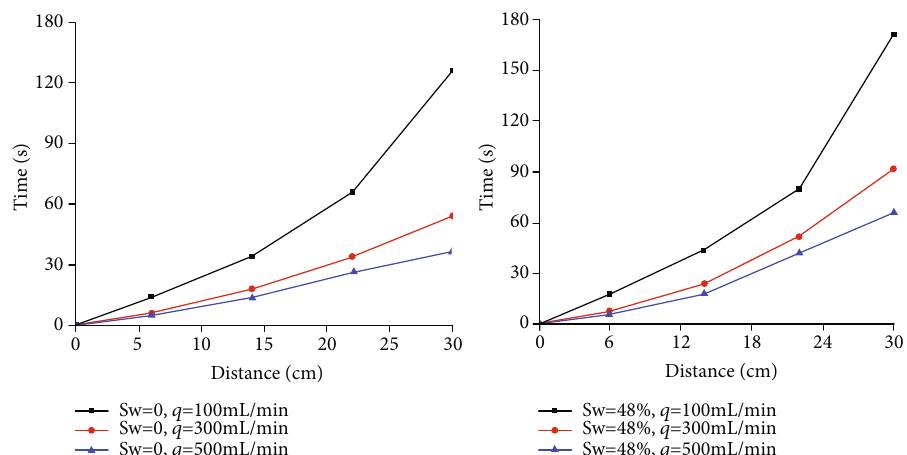
Figure 9: Time corresponding to the pressure drop propagated to each pressure measuring point in the Su3 core under the dry and bound water conditions.